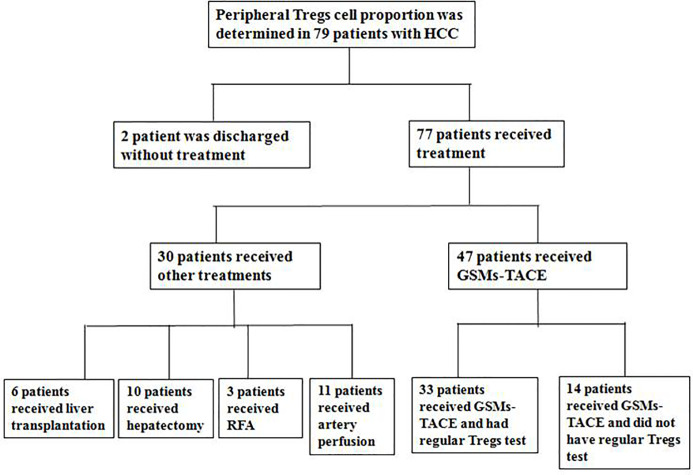
Flow chart of the enrollment of 33 HCC patients treated with GSMs-TACE. (RFA, radiofrequency ablation; HCC, hepatocellular carcinoma; GSMs-TACE, transarterial chemoembolization with gelatin sponge microparticles).